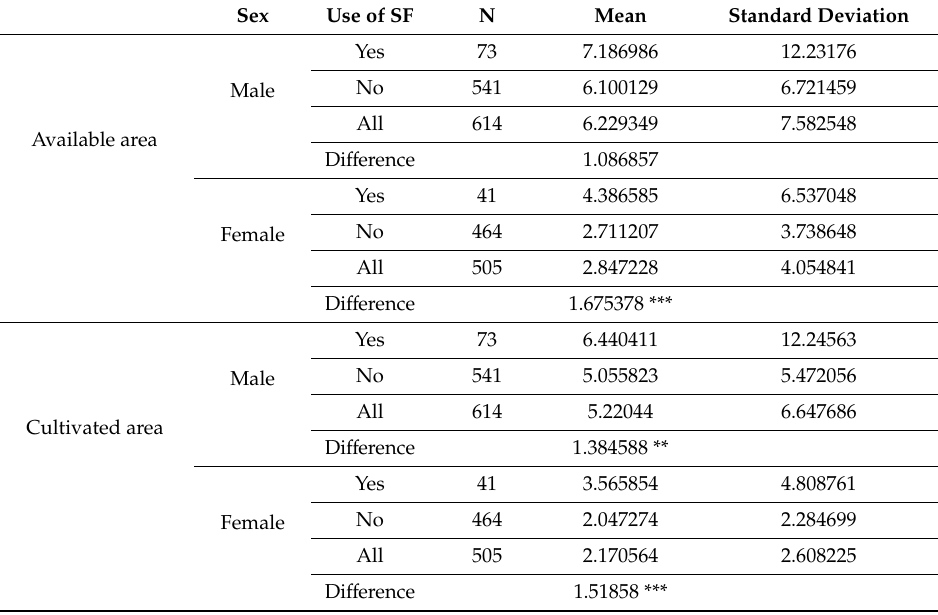
Table 5. Available and cultivated area by sex and status of adoption. Sex Use of SF N Mean Standard